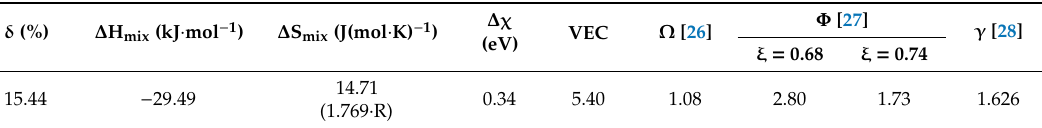
Table 2. Thermodynamic parameters calculated for the Co 15 Cr 15 Mo 25 Si 15 Y 15 Zr 15 alloy: atomic size mismatch ( δ ), mixing enthalpy ( ∆ H mix ), mixing entropy ( ∆ S mix ), electronegativity di ff erences ( ∆ χ